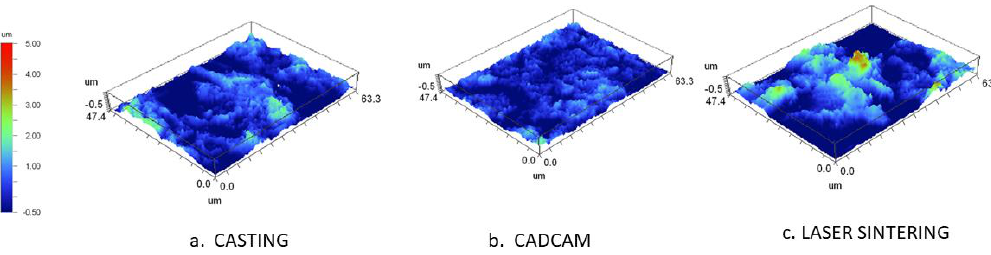
Figure 7. 3D topographic maps of three different models obtained by the White Light Interferometry (WLI) method: ( a ) Casting, ( b ) CADCAM, and ( c ) Laser sintering.